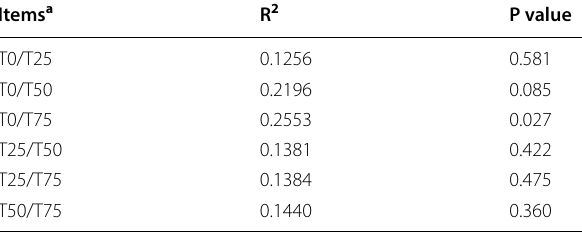
Table 5 Effects of BPS on the α-diversity of hindgut bacterial community of Holstein heifers (n